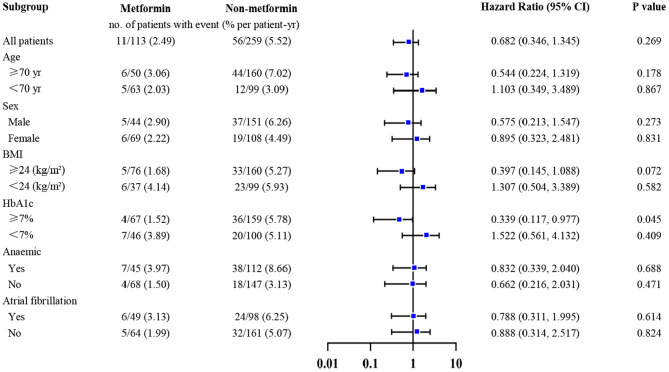
Association between metformin and all-cause mortality in selected subgroups adjusted for multiplicity. Metformin was only associated with lower all-cause mortality in patients whose HbA1c ≥7% [HR (95% CI) = 0.339 (0.117–0.977); P = 0.045]. The widths of the confidence intervals were adjusted for multiplicity, using the stepwise regression, with a threshold of 0.1. Adjusted covariables included age, gender, body mass index, cigarette smoking, systemic blood pressure, diastolic blood pressure, New York Heart Association class, left ventricular ejection fraction, duration of diabetes and heart failure, whether living with hypertension, atrial fibrillation, coronary heart disease, or cerebral infarction, glycated hemoglobin, estimated glomerular filtration rate, hemoglobin, low-density lipoprotein cholesterol, high-density lipoprotein cholesterol, triglyceride, left atrial, sulfonylureas, glinides, glucosidase inhibitors, insulin.